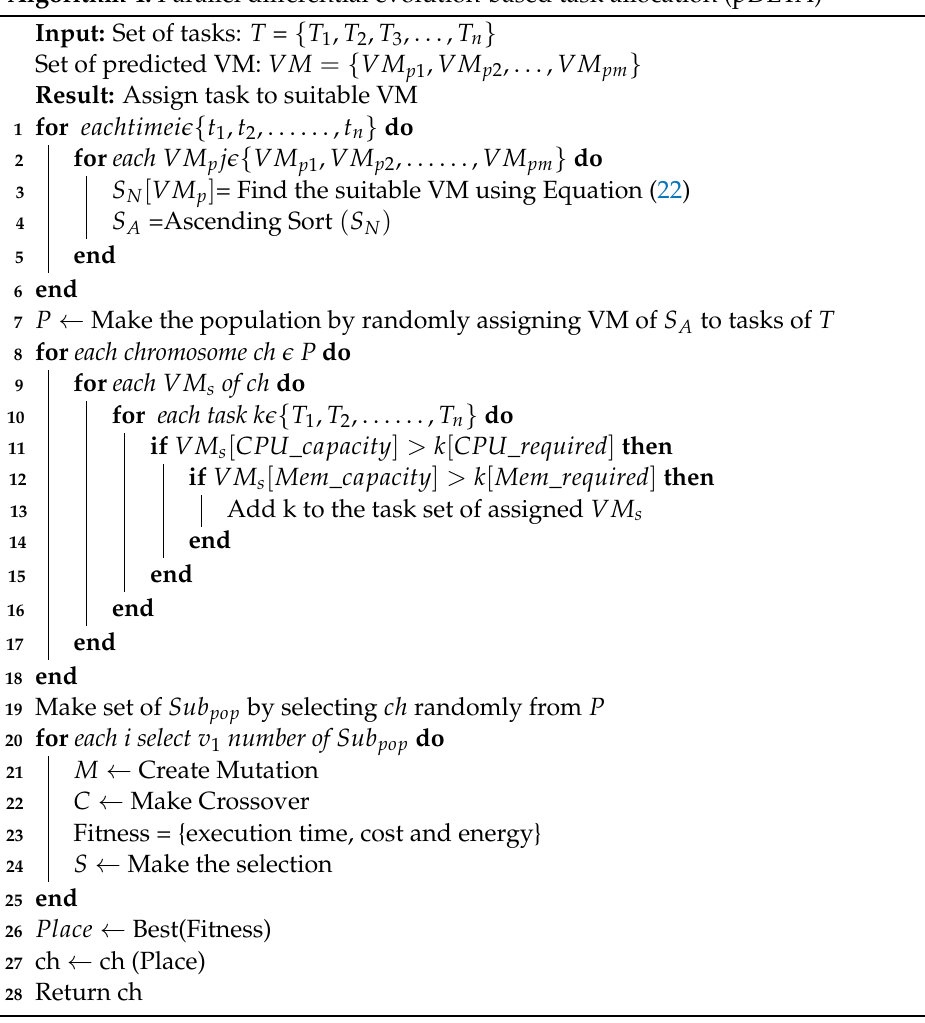
Algorithm 4: Parallel differential evolution-based task allocation